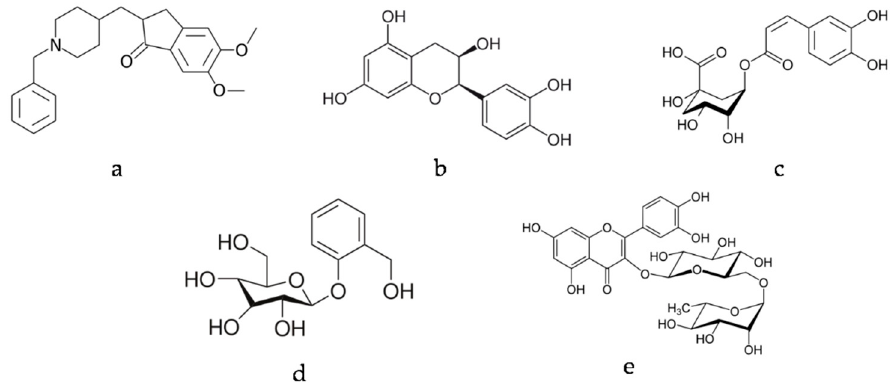
Figure 1. Structures of ligand molecules used for molecular docking: a , donepezil; b , (-)-epicatechin; c , chlorogenic acid; d , salicin; e , rutin.